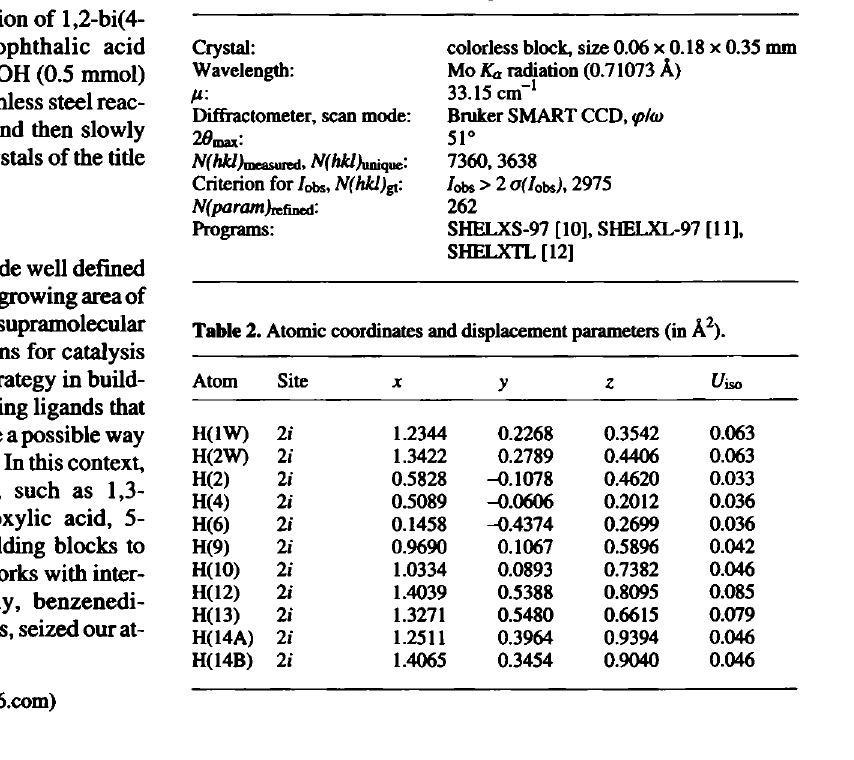
Table I. Data collection and handling.